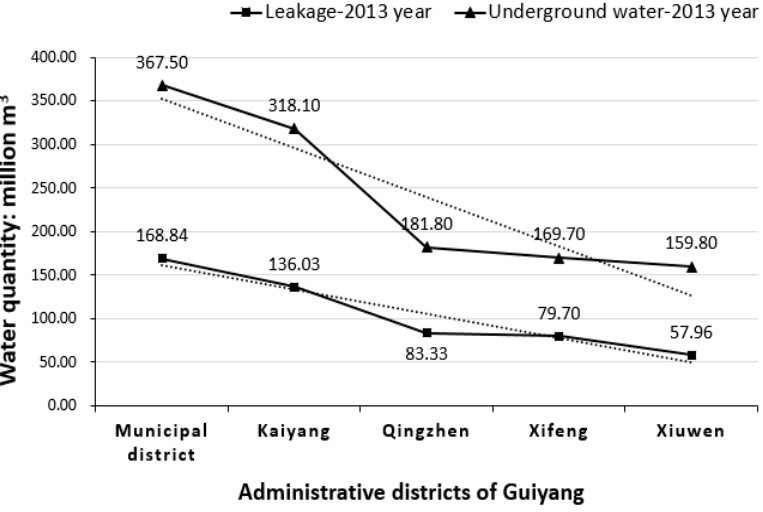
Figure 8. Contrast between simulation of leakage and groundwater in each district of Guiyang.